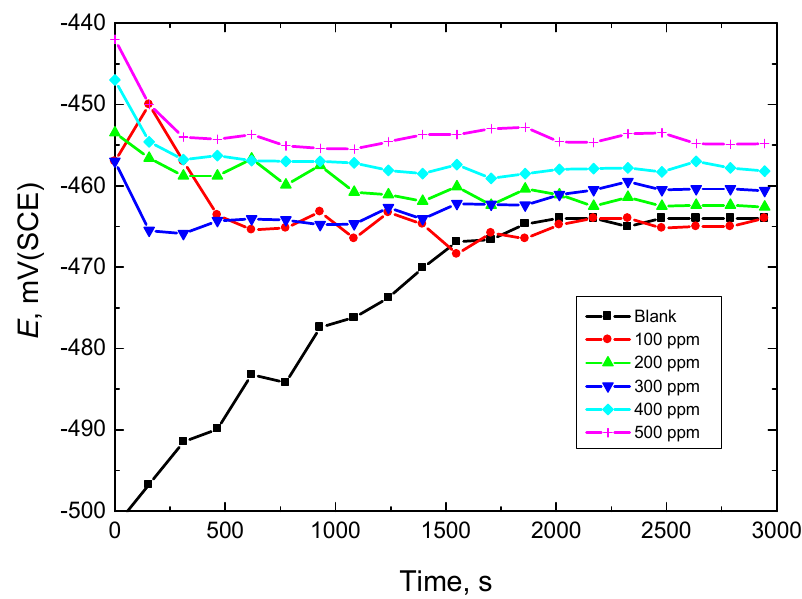
Figure 2. Plots of OCP vs. time for mild steel in 0.5 M HCl solution in absence and presence of numerous amylopectin concentrations at 303 K.